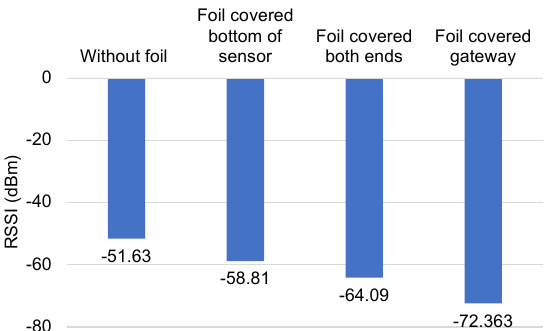
Figure 3. Signal strength of Oyster AU 915 with different foil cover scenarios at a depth of 100cm